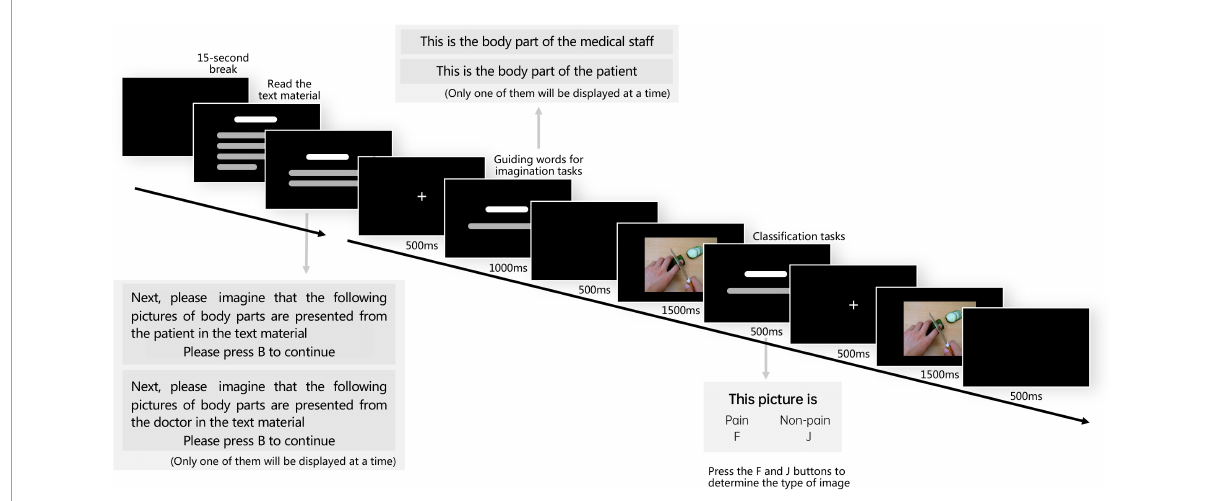
FIGURE2 Flow diagram of experimental procedure. The experiment had two parts: reading text and viewing pictures; the low moral judgment group read low moral text and the high moral judgment group read high moral